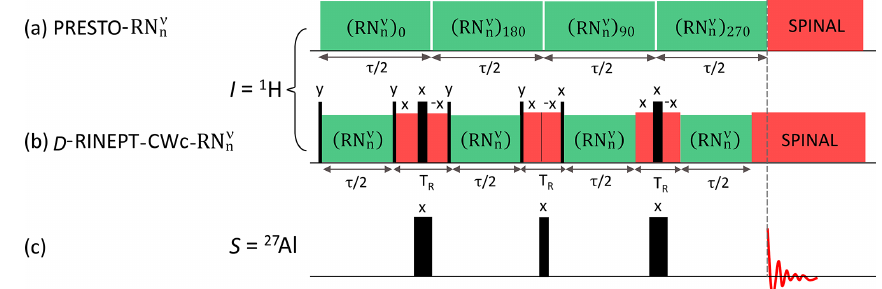
Figure 1. The 1 H → 27 Al (a, c) PRESTO-R N ν n and (b, c) D -RINEPT-CWc-R N ν n pulse sequences. Those applied to the 1 H channel are displayed in panels (a) and (b) , whereas that applied to the 27 Al channel is shown in panel (c) . The narrow and broad black bars represent π/ 2 and π pulses, respectively. The acquisition of the free-induction decays (FIDs) (indicated with the vertical dashed line) starts after (a) the end of the R N ν n block in the case of PRESTO or (b) on top of the echo shifted with T R / 2 with respect to the end of the last recoupling block in the case of